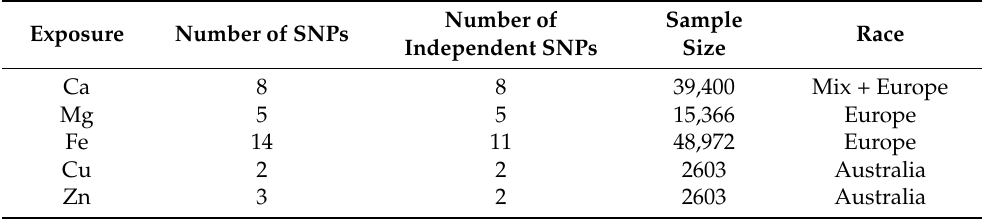
Table 1. Dataset of the Mineral Information.